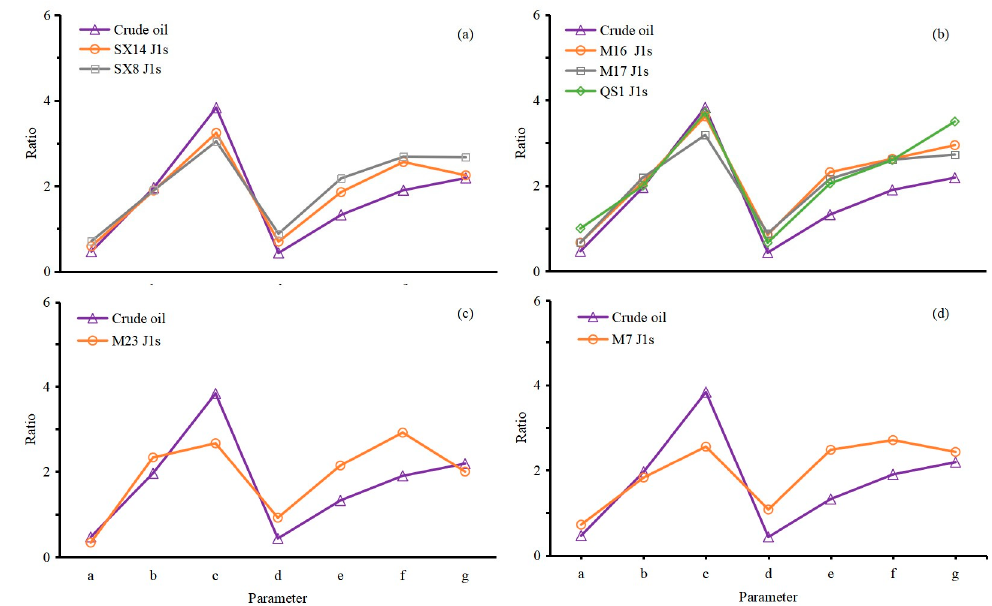
Figure 6. Cross-plots of A 1 vs. A 2 ( a ) and K 1 vs. K 2 ( b ) for the light hydrocarbons associated with the natural gas in the Eastern belt around the Penyijingxi sag, Junggar Basin (Plate from ref. [50]).